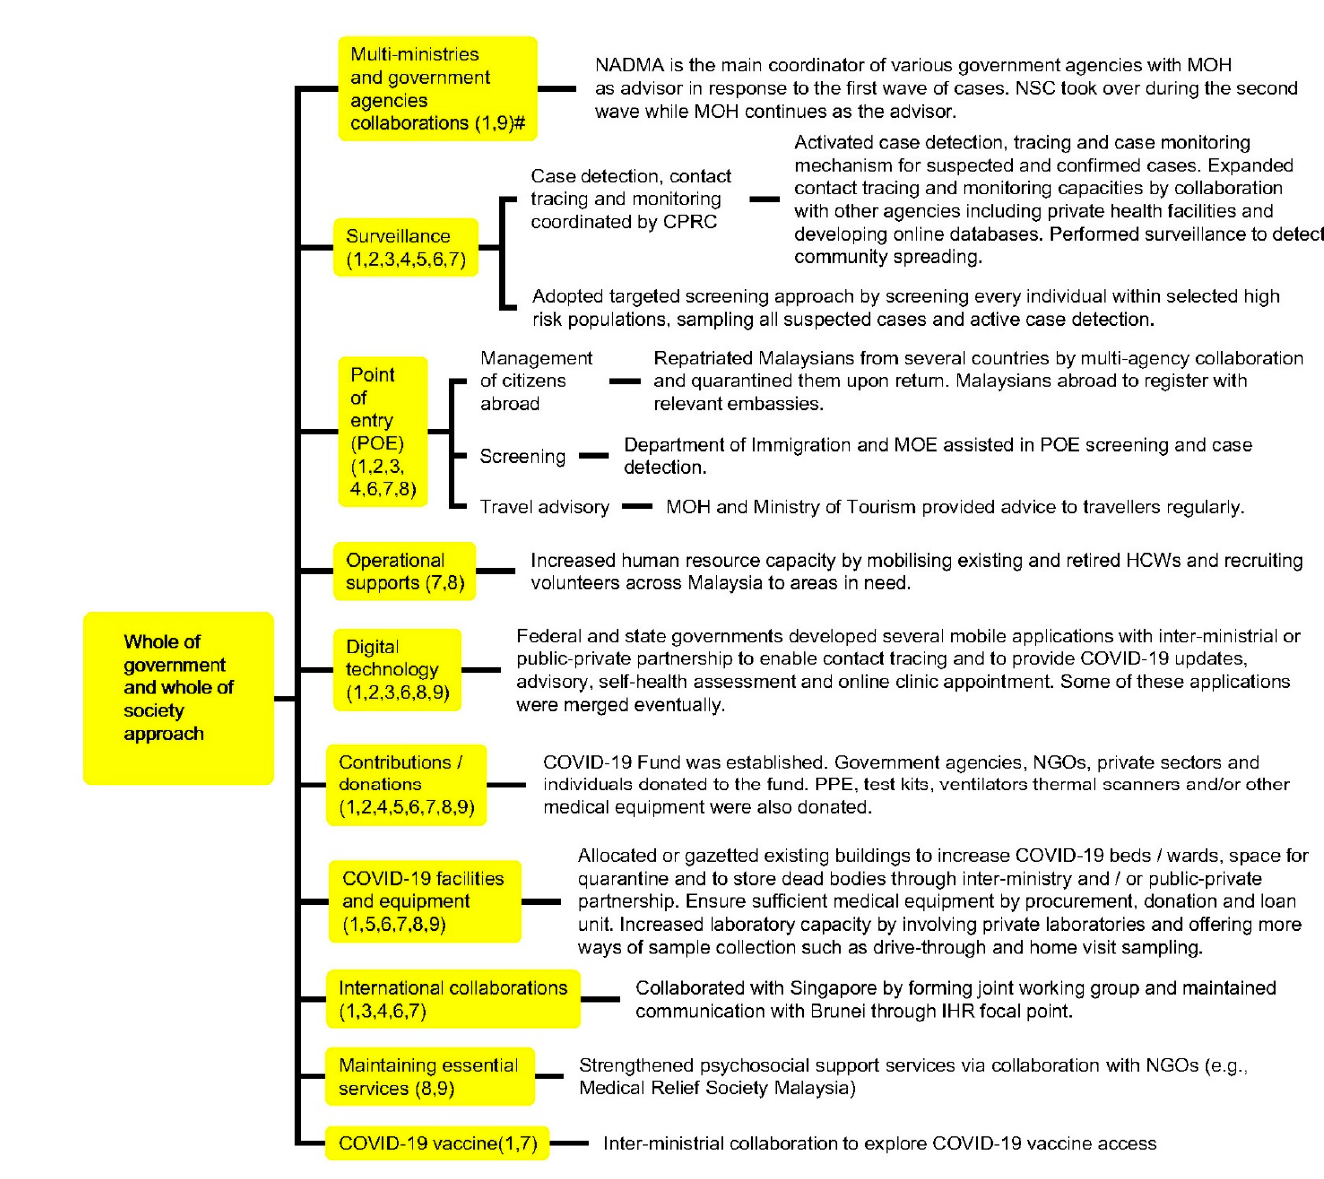
Figure 3. Whole of government and whole of society approach taken by Malaysia in response to the COVID-19 pandemic. # Numbers in parentheses denote WHO Pillars.